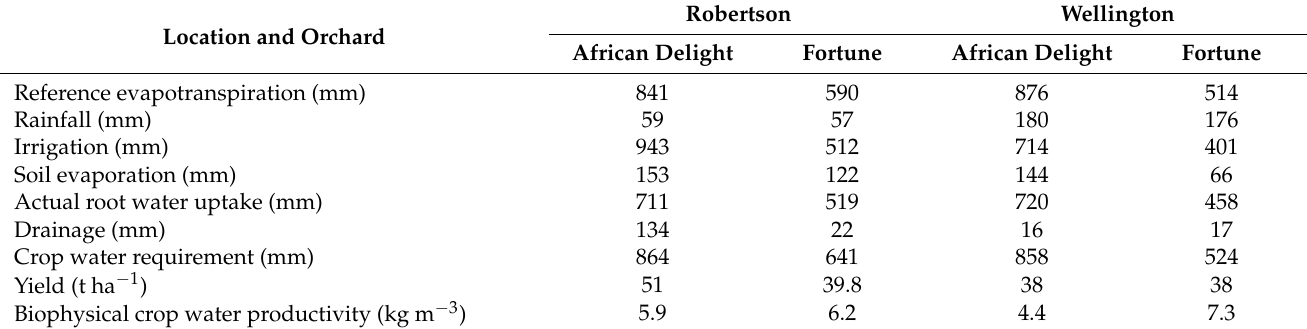
Table 4. Growing season reference evapotranspiration, water balance components (rainfall, irrigation, soil evaporation, actual root water uptake and free drainage), crop water requirements, yield and biophysical crop water productivity for four plum orchards.